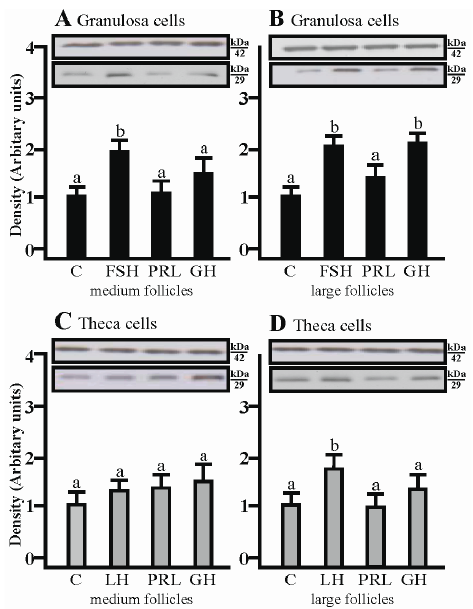
Figure 2. Effect of FSH, LH, PRL and GH on AQP1 protein expression in medium and large follicles. ( A , B ) in the granulosa cells and theca cells ( C , D ). FSH, follicle-stimulating hormone; LH, luteinizing hormone; PRL, prolactin; GH, growth hormone. Values are expressed as means ± S.E.M from five separate experiments, each performed in triplicates ( p < 0.05 compared with controls). AQP1 protein levels was performed (29 kDa) and normalized against β -actin (42 kDa). Values are expressed as means ± S.E.M ( p < 0.05, compared with controls). Statistically significant differences between treatments are indicated by different letters (a, b). C: control.